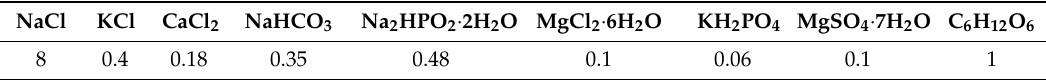
Table 1. SBF chemical composition (g /